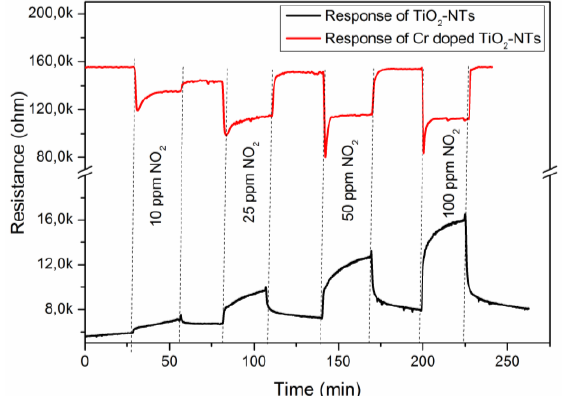
–NTs sensors having a thickness of 2 concentrations in argon carrier gas at 500 2